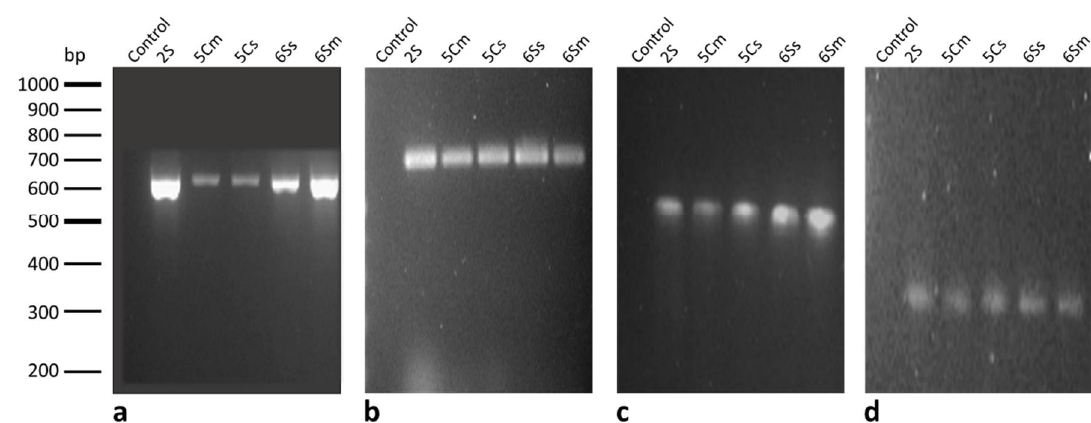
Figure 3. Gel electrophoresis. DNA molecular market: GeneRuler-100bp-Plus. Lines show negative controls (Control) and B. subtilis strains (2S, 5Cm, 5Cs, 6Ss, 6Sm). ( a ) PCR products of the internal fragment of the ‘Bacillus subtilis group’ of 16S-rRNA gene using the species-specific primers Bsub5F-Bsub3R (600 bp). ( b ) PCR products of srfAA gene (surfactin) (700 bp). ( c ) PCR products of bacA gene (bacylisin) (approx. 500 bp). ( d ) PCR products of bmyB gene (bacillomycin) (approx. 300